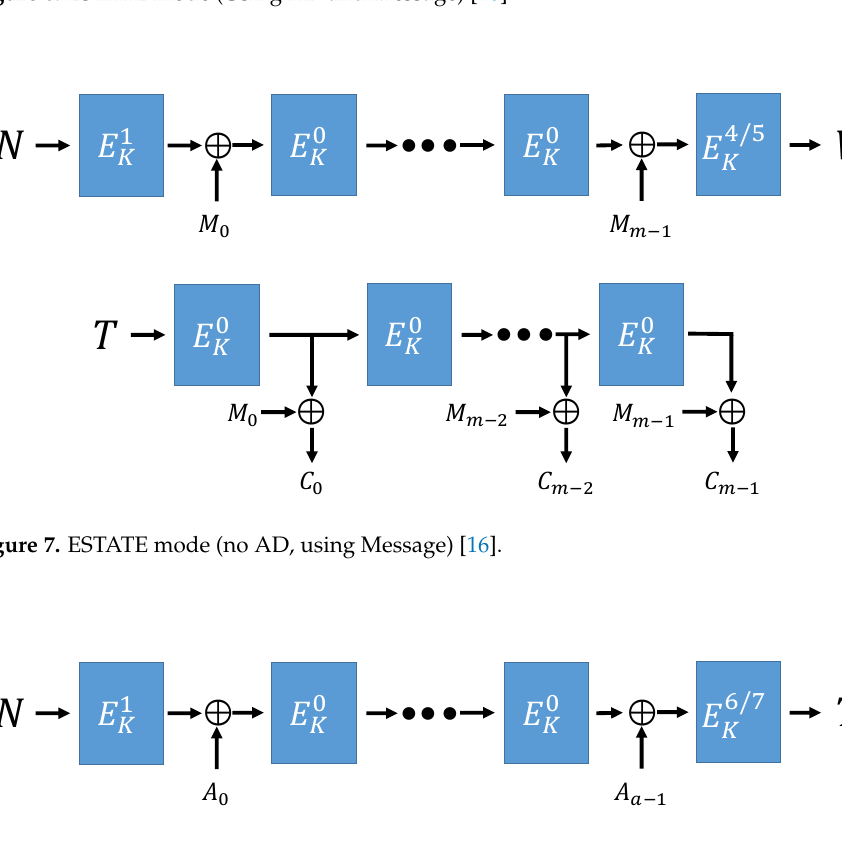
Figure 8. ESTATE mode (using AD, no Message)